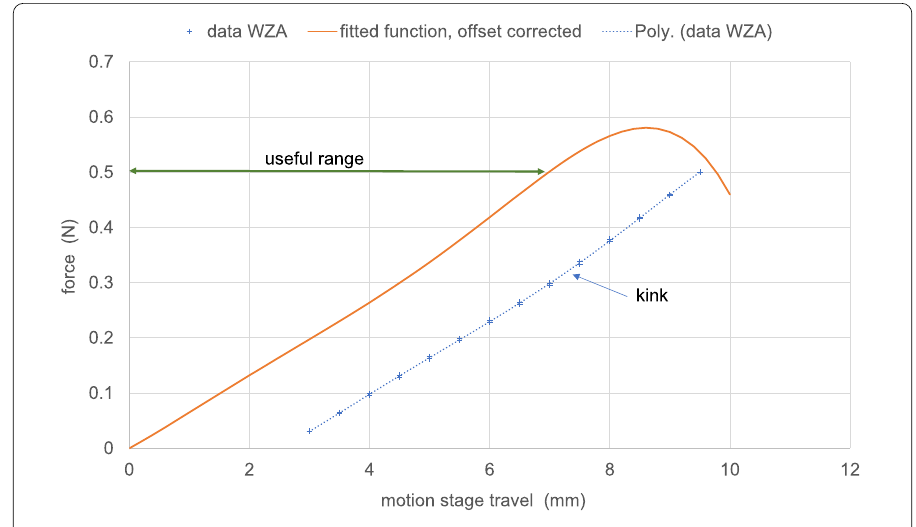
Figure 12 Spring force versus motion stage travel data. Shown are data (crosses), a polynomial fit of order 5 through the data points, and this fit shifted to left passing the origin in its quasi-linear part (solid line)